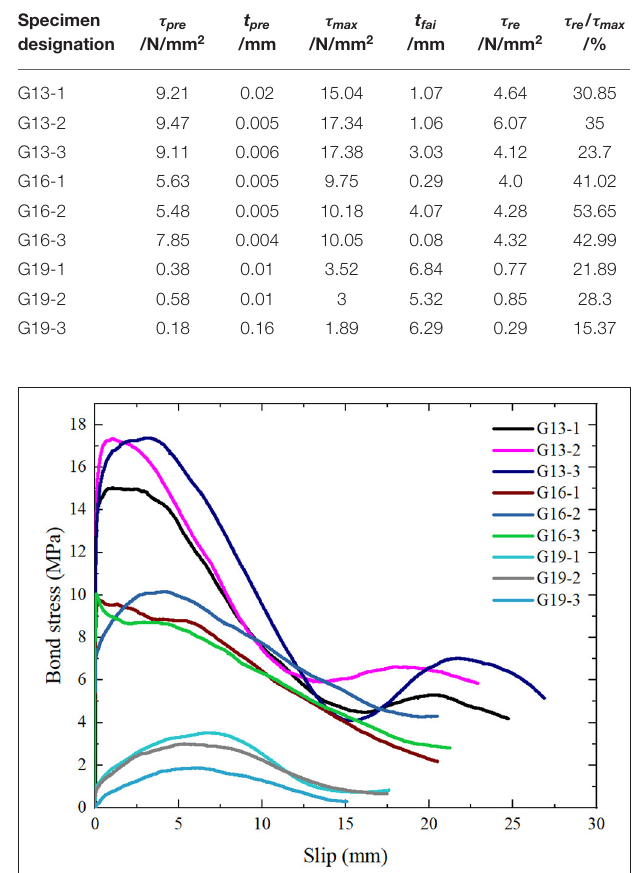
FIGURE 3 | Bond stress vs. slip at free end of specimens with different